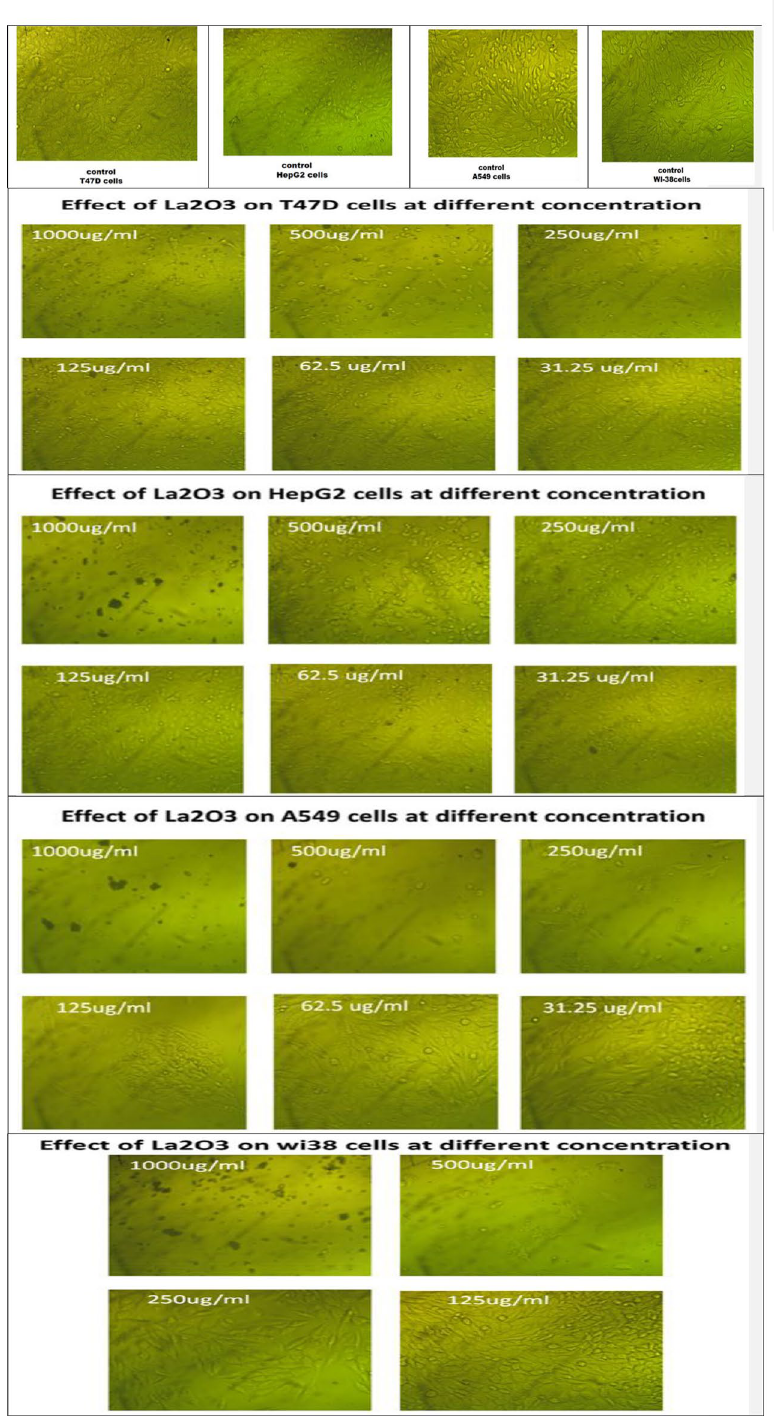
Figure 5. Images of treated cell lines with different biosynthesized nanoparticles compared with untreated cell lines